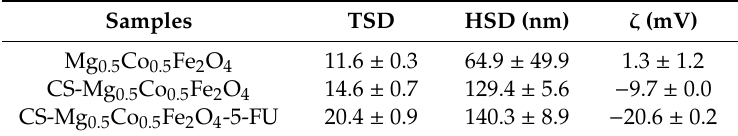
Figure 1. TEM images of ( A ) Mg 0.5 Co 0.5 Fe 2 O 4 , ( B ) CS-Mg 0.5 Co 0.5 Fe 2 O 4 and ( C ) CS-Mg 0.5 Co 0.5 Fe 2 O 4 -5FU Ps. Table 1. TEM size diameter (TSD), hydrodynamic size diameter (HSD) and zeta potential ( ζ ) of the synthesized MNPs.